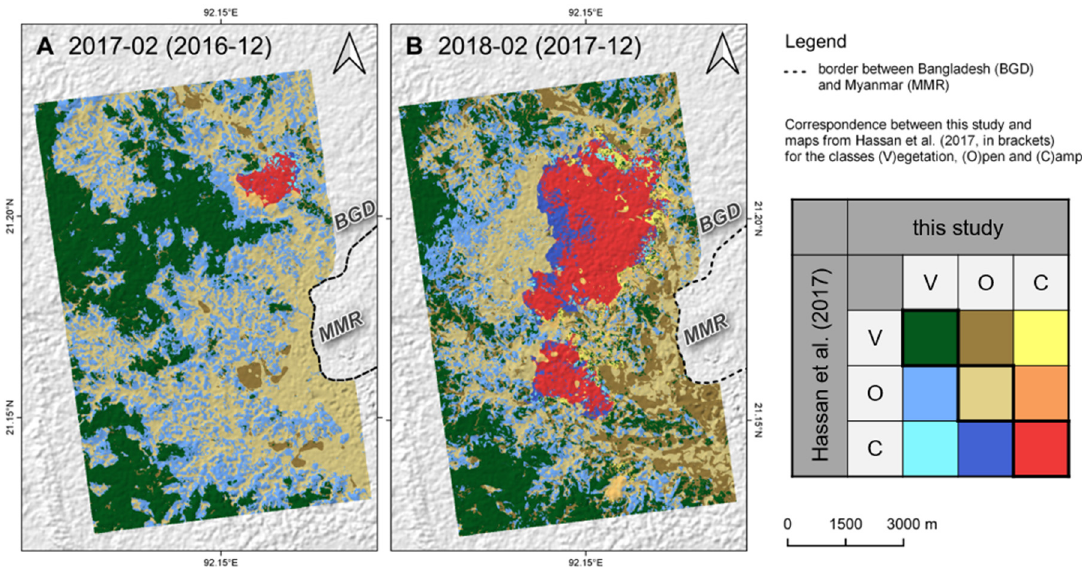
Figure 8. Correspondence and di ff erences between the results of this study and the land cover maps produced by Hassan et al. in 2018 [23] for the pre-influx situation ( A ) and the post-influx situation ( B ). Pixels in green, beige, and red have the same class in both studies (V = vegetation, O = open, C = camp). The other hues of the color matrix indicate the di ff erences regarding these classes assigned in this study (columns) and the study of Hassan et al. in 2018 (rows).